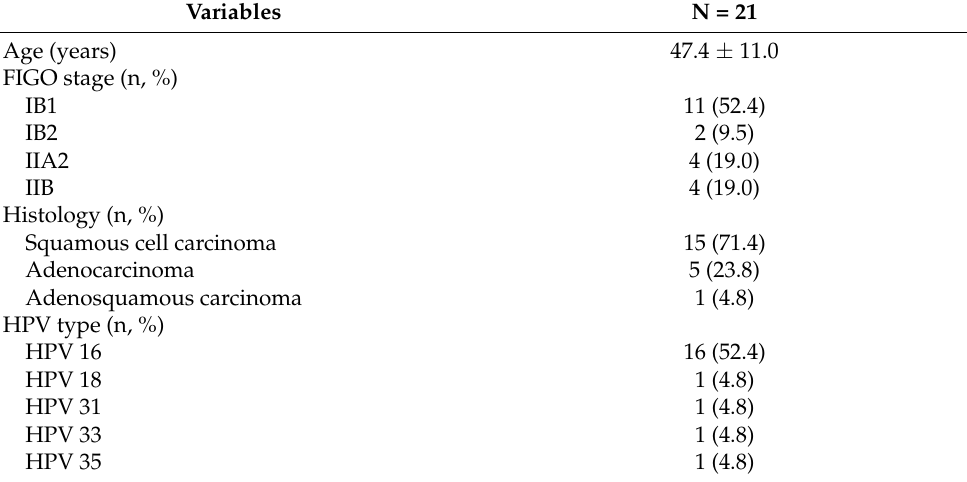
Table 1. Clinicopathologic characteristics of 21 cervical cancer samples. All 21 patients were staged following revised 2009 FIGO (International Federation of Gynecology and Obstetrics) staging